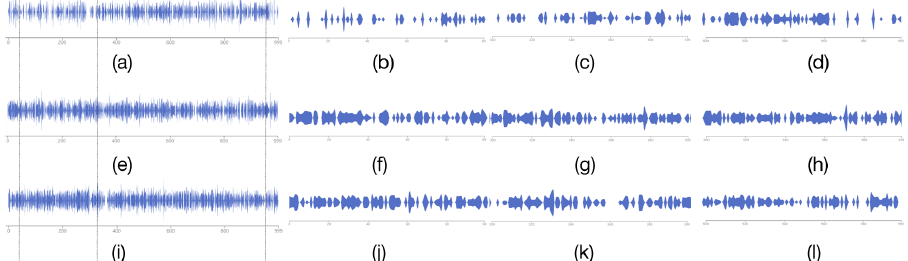
Figure 10. Using the magnifying glass component. ( a ) The 1000 timesteps of pocket 12. ( b ) The 0–99 timesteps of pocket 12. ( c ) The 300–399 timesteps of pocket 12. ( d ) The 900–999 timesteps of pocket 12. ( e ) The 1000 timesteps of pocket 4. ( f ) The 0–99 timesteps of pocket 4. ( g ) The 300–399 timesteps of pocket 4. ( h ) The 900–999 timesteps of pocket 4. ( i ) The 1000 timesteps of pocket 1. ( j ) The 0–99 timesteps of pocket 1. ( k ) The 300–399 timesteps of pocket 1. ( l ) The 900–999 timesteps of pocket